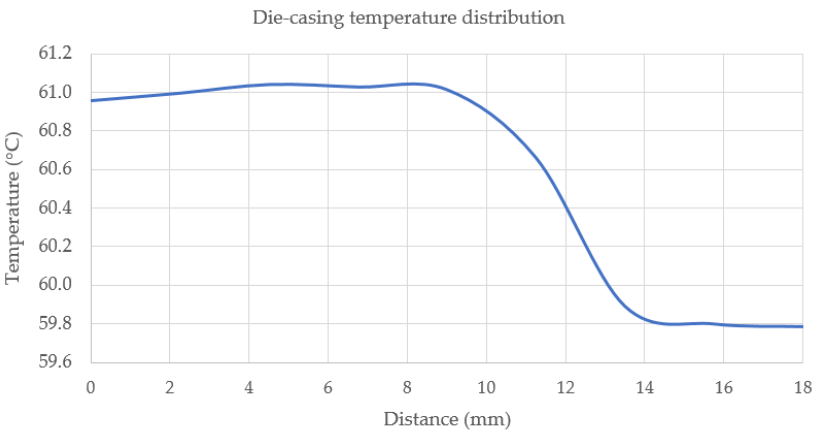
Figure 9. Results of the simulations carried out the temperature on the path between the die of the semiconductor diode and the point of the housing, the temperature of which is closest to the die temperature. The result obtained for Pj = 9.91 W.